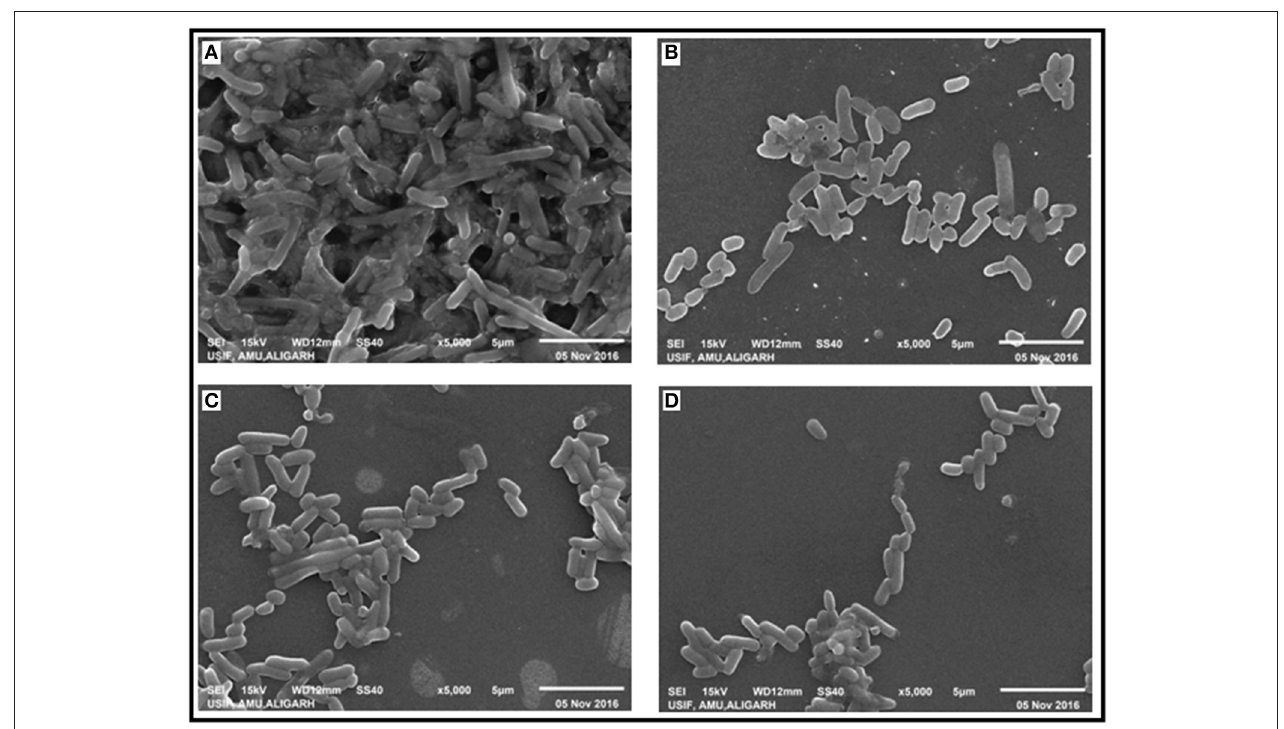
FIGURE 5 | Effect of luxS down regulation on biofilm architecture. SEM images (A) AK-117 biofilm as control (B) AK-LV1 (C) AK-LV2 (D) AK-LV3.